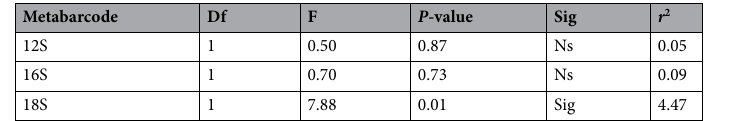
Table 2. PERMANOVA results for three metabarcoding assays (12S, 16S, 18S) comparing the number of reads of taxa in stomach contents from predators ( S. mokarran ) vs. that of their whole prey ( Urolophus sp. and A. rostrata